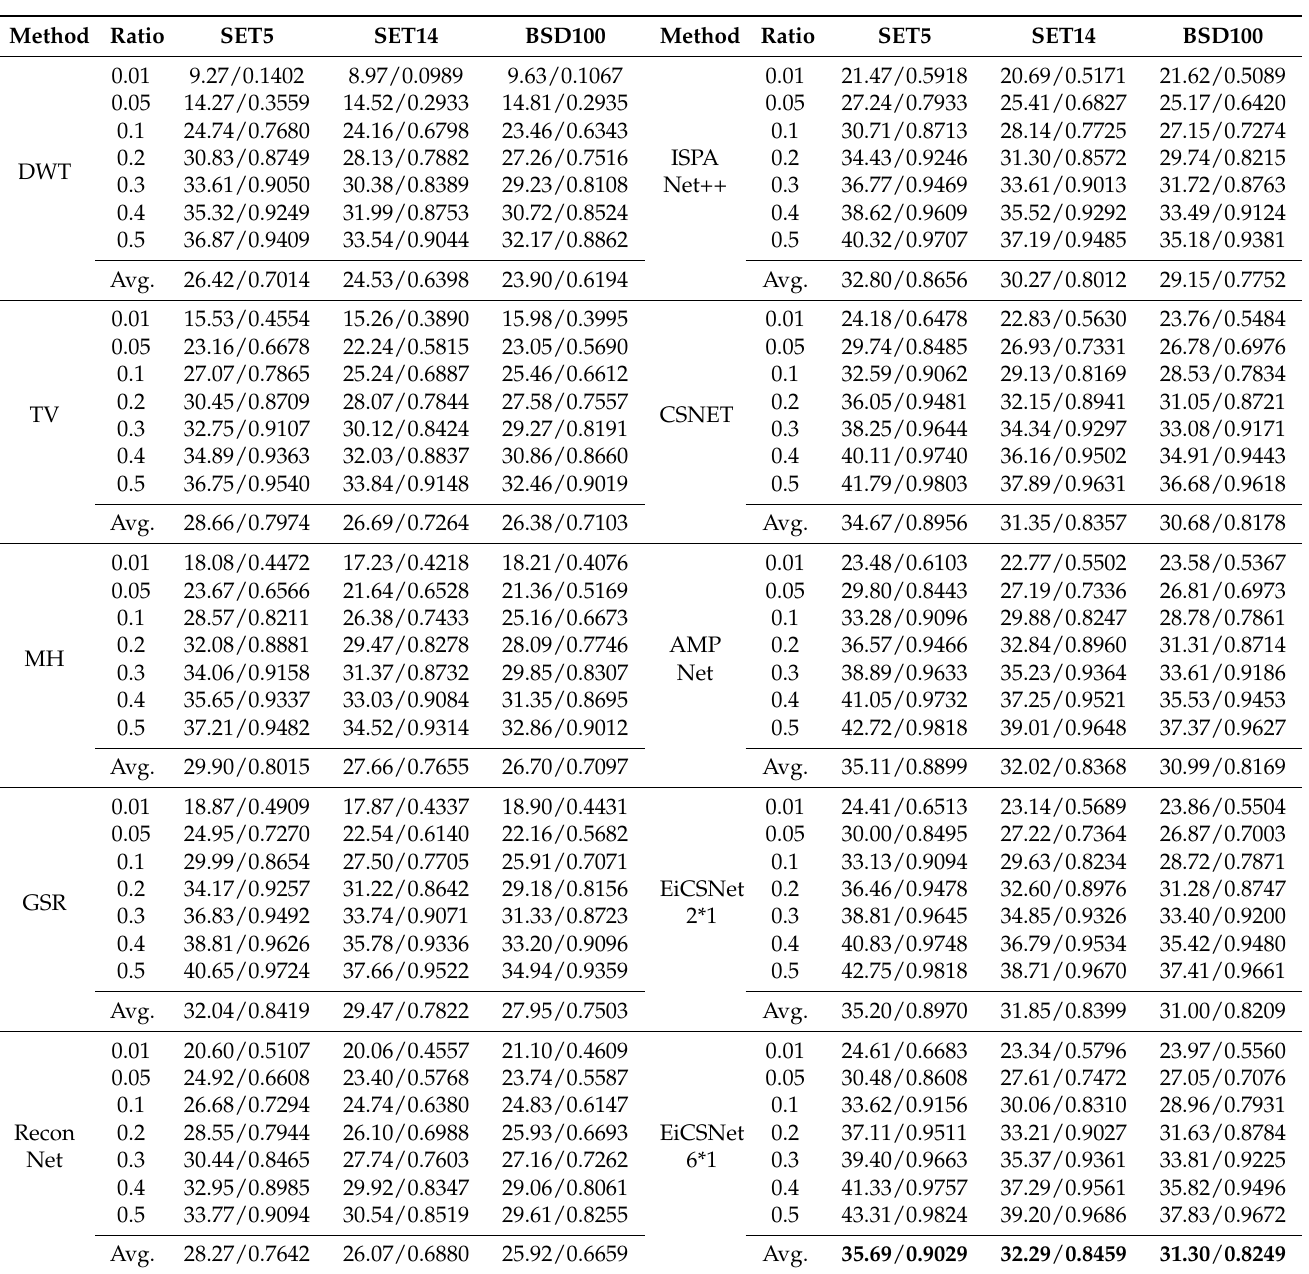
Table 4. The performance results from the different methods. All methods were tested with the three testing datasets and the seven sampling ratios. The indicators are shown in PSNR/SSIM format. The best indicators are marked in bold for each